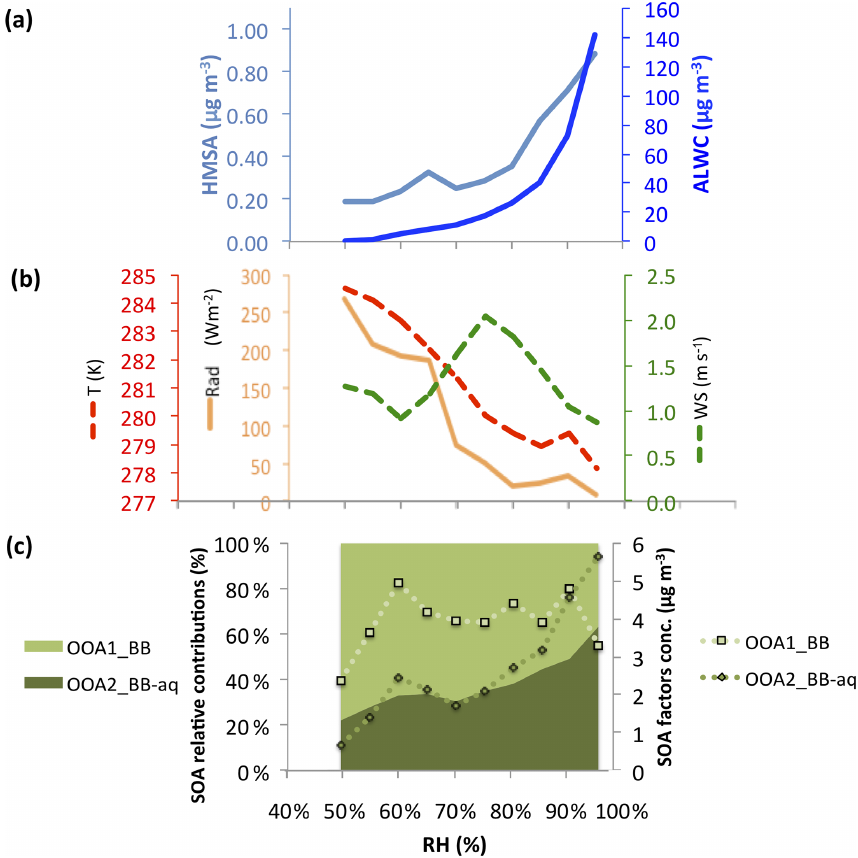
Figure 8. Variations of meteorological and chemical parameters as a function of RH during the BO fall 2011 campaign. The data were binned according to the RH (5% increment), and mean values are shown for each bin. (a) Aerosol liquid water content (ALWC) and hydroximethansulfonic acid (HMSA). (b) Air temperature together with solar radiation and wind speed (WS) measured at ground level. (c) Variations in the contributions of the two BB-influenced OOA factors identified (OOA1_BB and OOA2_BB-aq) in both absolute (µgm − 3 ) and relative (% of OOA)